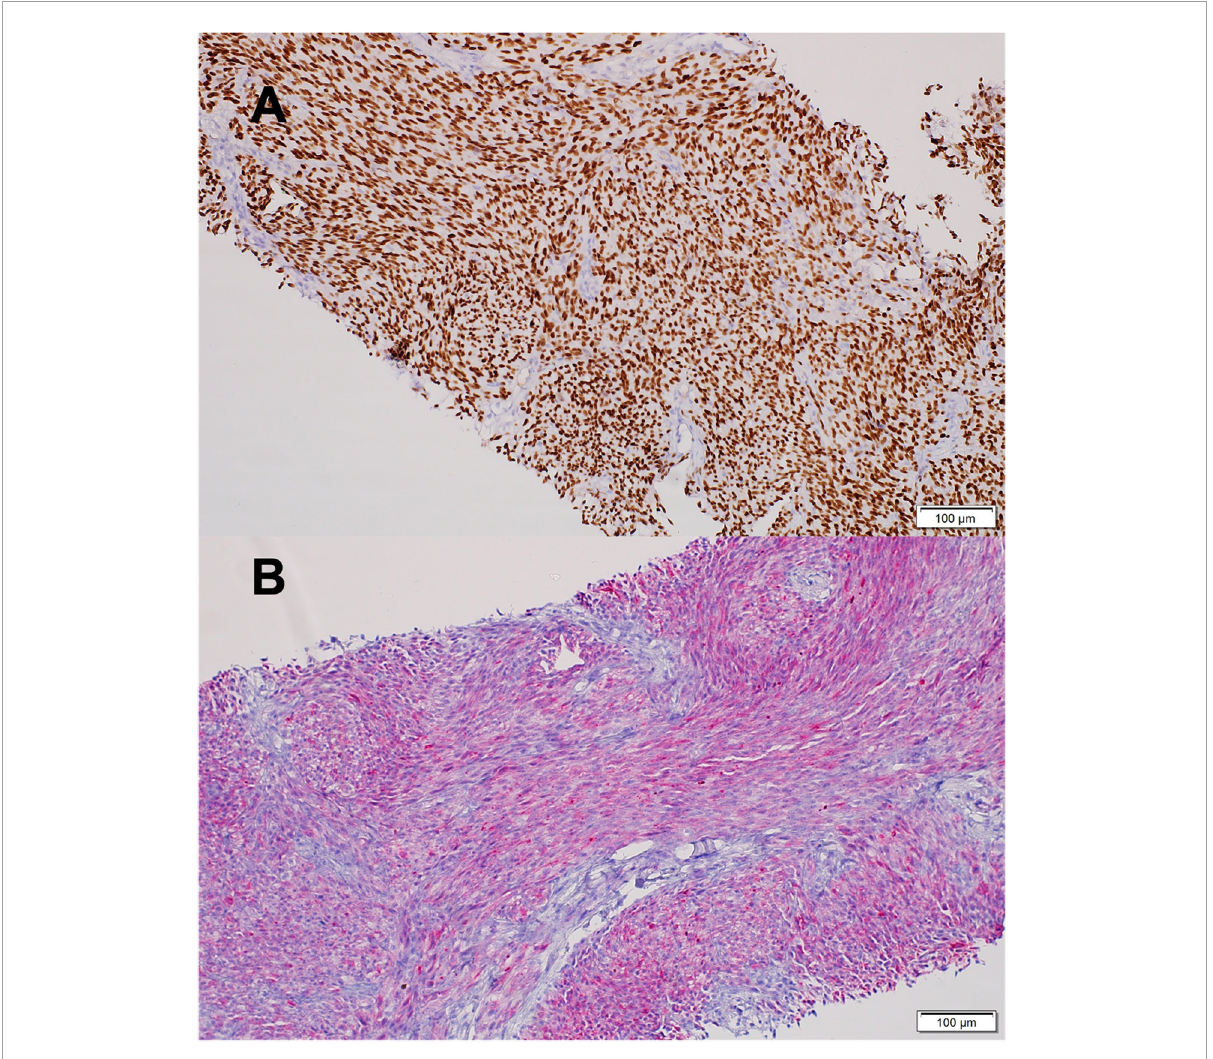
FIGURE1 Clear Cell Sarcoma histology. (A) SOX10 positive staining. (B) MART1 positive staining. Scale bars 100 mm. Images were acquired by brightfield Olympus BX53 microscope with X20 air objective. (Olympus Life Science, Waltham, MA, United States), and Llumins 5MP Bright Field Camera (Llumins, Johnannesburg, South Africa). Software- Llumins ToupView